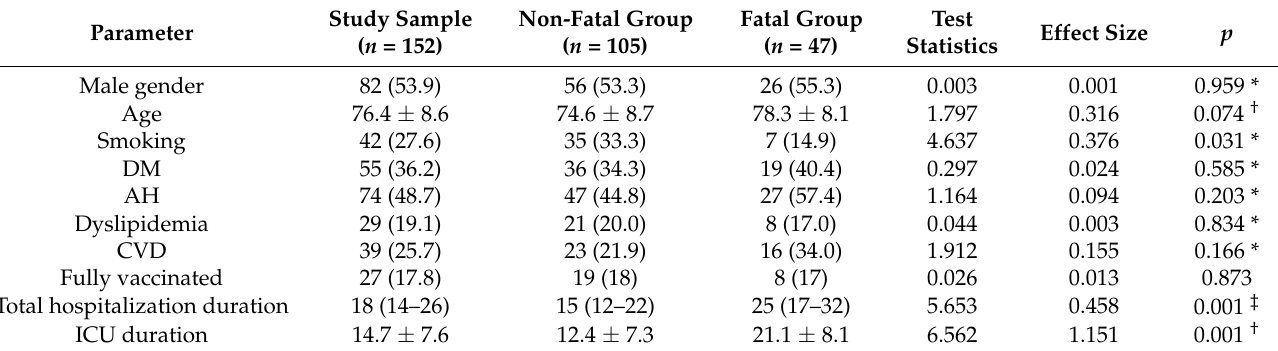
Table 1. Anthropometric and anamnestic data of the study